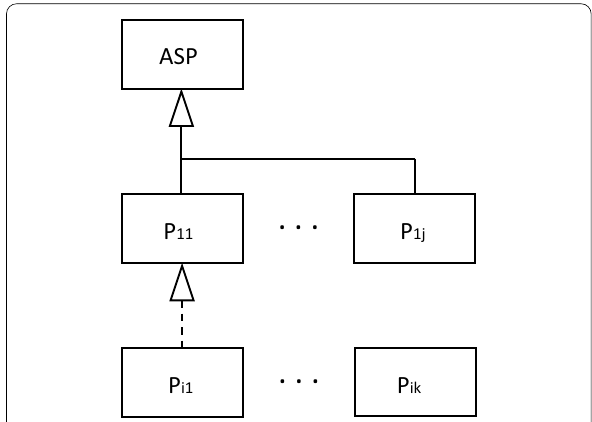
Fig. 13 Metamodel for an ASP and its derived patterns